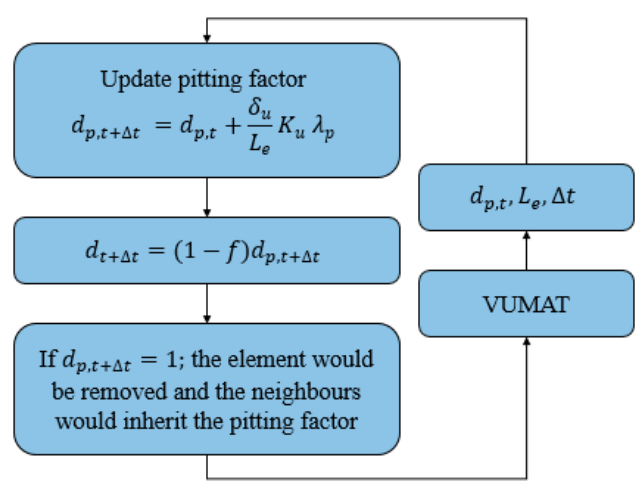
Figure 3. Schematic overview of the subroutine.